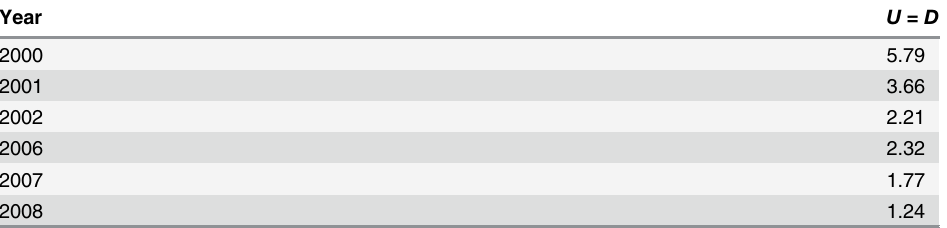
Table 1. Model parameter values used to generate the distributions in Fig 1. Empirically, we find that stock return distributions are symmetric, reducing our model to only one free parameter, D = U . Similar results are obtained using direct fits and by using the standard deviation of the distribution (see